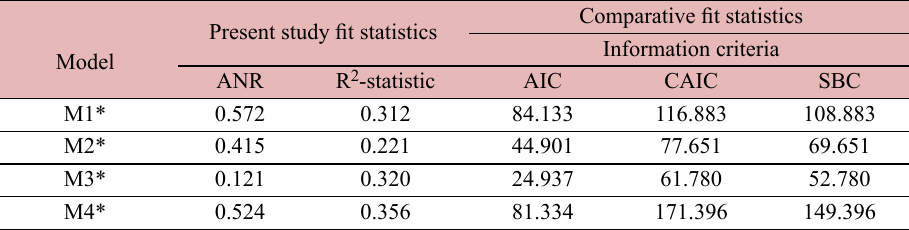
Table 2. Comparative fit